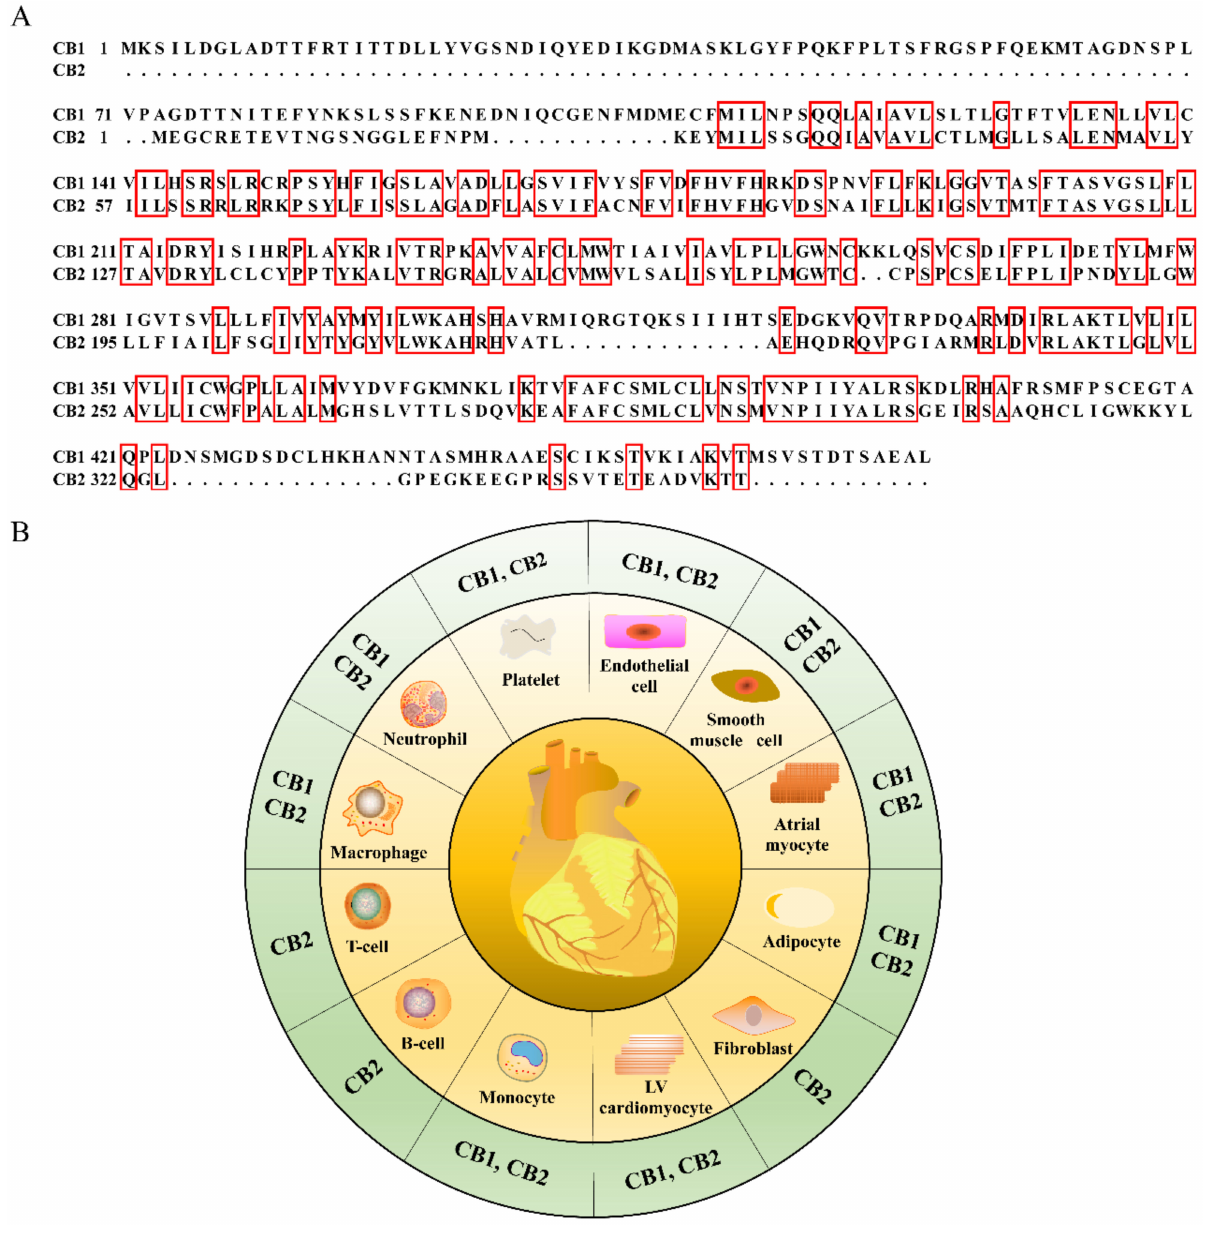
Figure 3. The amino acid sequence alignment of mouse CB1 with the CB2 receptor ( A ) and the cell tropism of CB1 and CB2 receptors within heart ( B ). The identical amino acid sequences are highlighted with red boxes in ( A